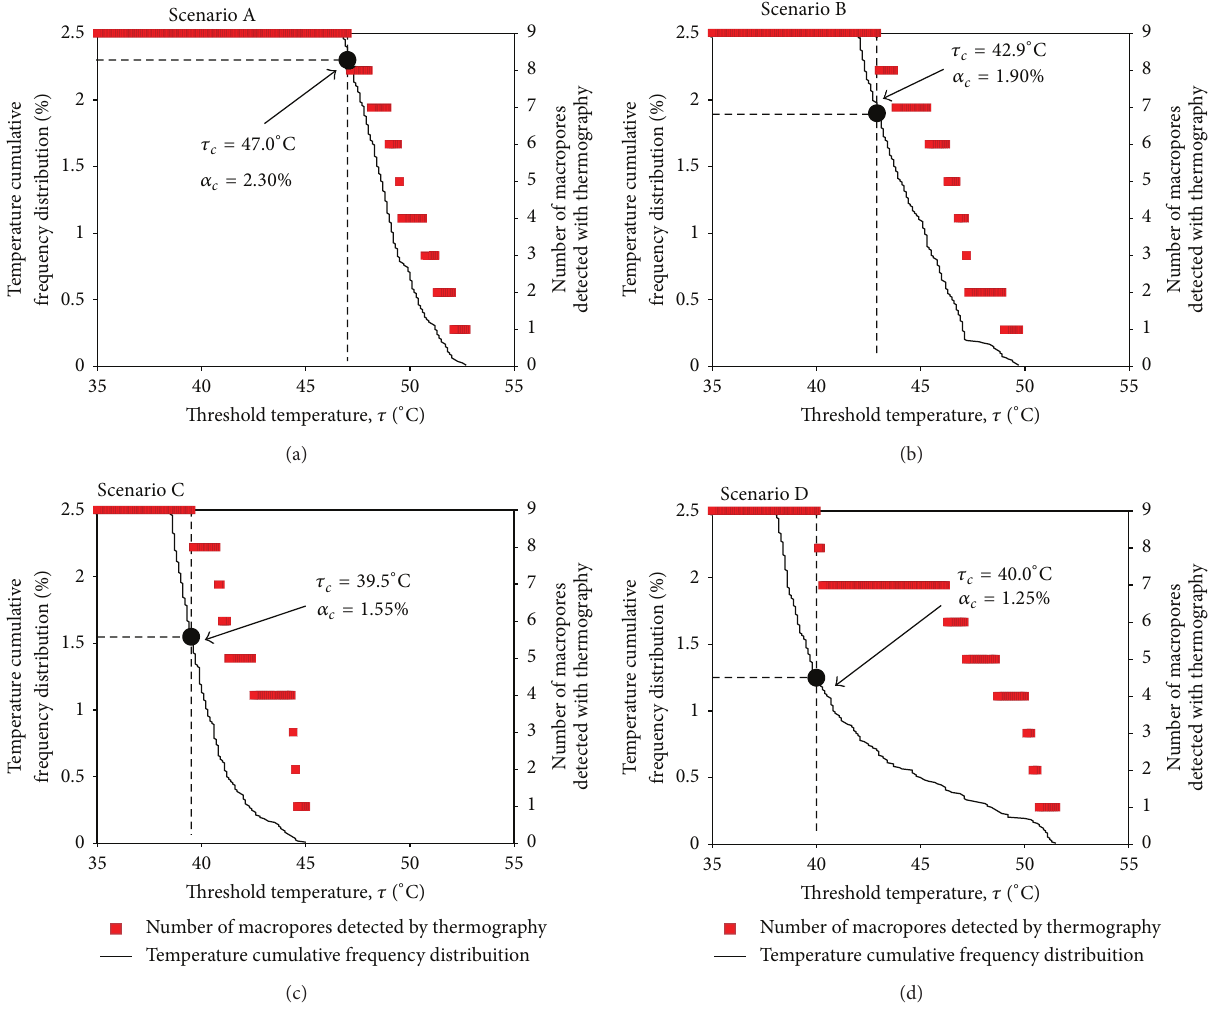
Figure 4: Relation between threshold temperature ( 𝜏 ) and the number of macropores detected with thermography, for the four scenarios: (a) Scenario A; (b) Scenario B; (c) Scenario C; and (d) Scenario D. Temperature cumulative frequency distribution curves are also plotted, up to 2.5%. Critical threshold temperature ( 𝜏 𝑐 ) and corresponding critical threshold percentage of pixels ( 𝛼 𝑐 ) are identified.